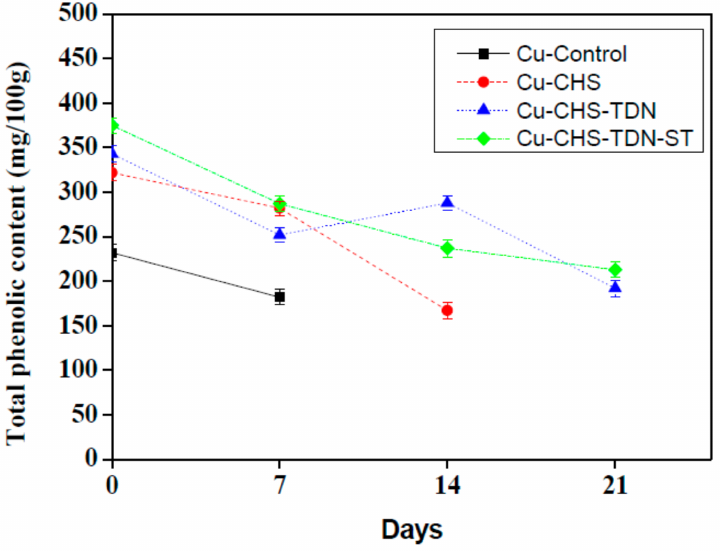
Figure 4. Effect of coating treatments on total phenolic